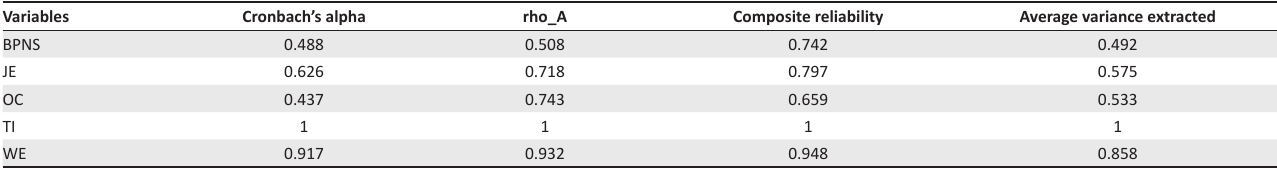
TABLE 4: Composite reliability, Cronbach’s alpha and average variance expected/extracted, outer model (Round 1). Variables